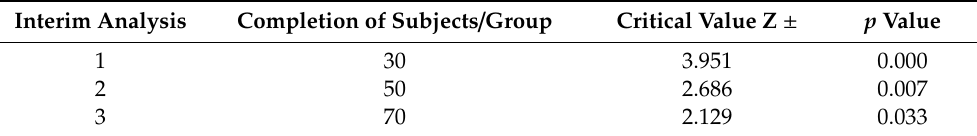
Table 5. Interim Monitoring